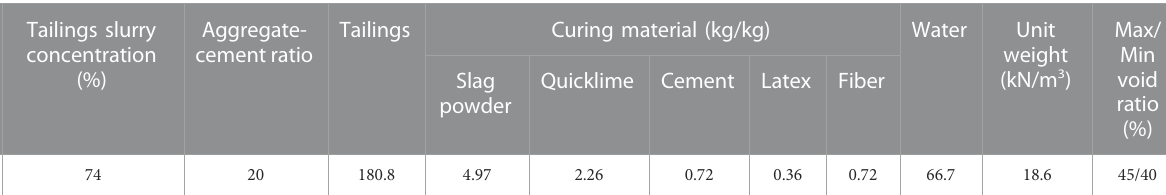
TABLE 1 Mix ratio for the triaxial shear test on concentrated full tailings.